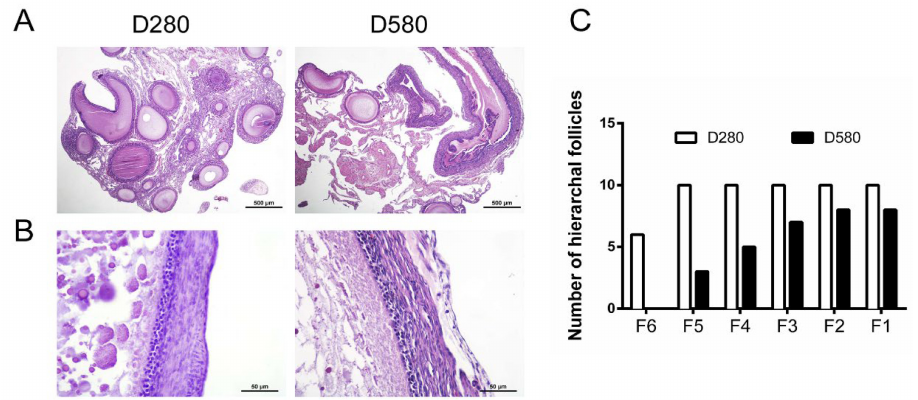
Figure 1. Ovarian histology and the number of hierarchical follicles (F6–F1) in D280 and D580 hens. ( A ) H&E staining of ovarian tissues of D280 and D580 hens. Scale bar: 500 µ m. ( B ) Follicular morphology in the SYFs of the D280 and D580 hens. Scale bar: 50 µ m. ( C ) The numbers of hierarchical follicles were counted in hens aged 280 and 580 days (n =